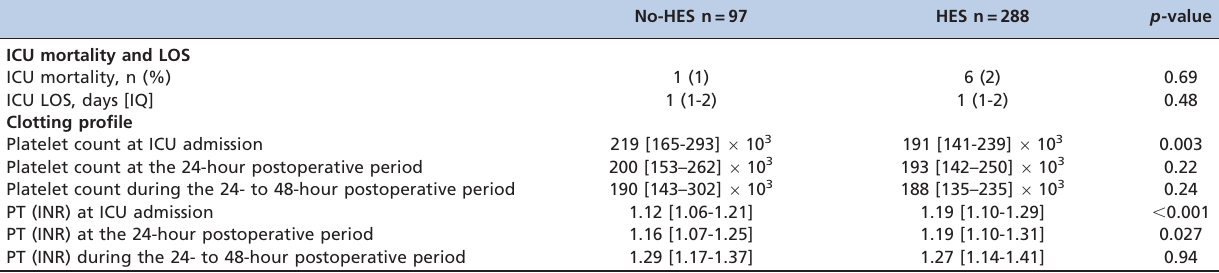
Table 3 - Secondary objectives.